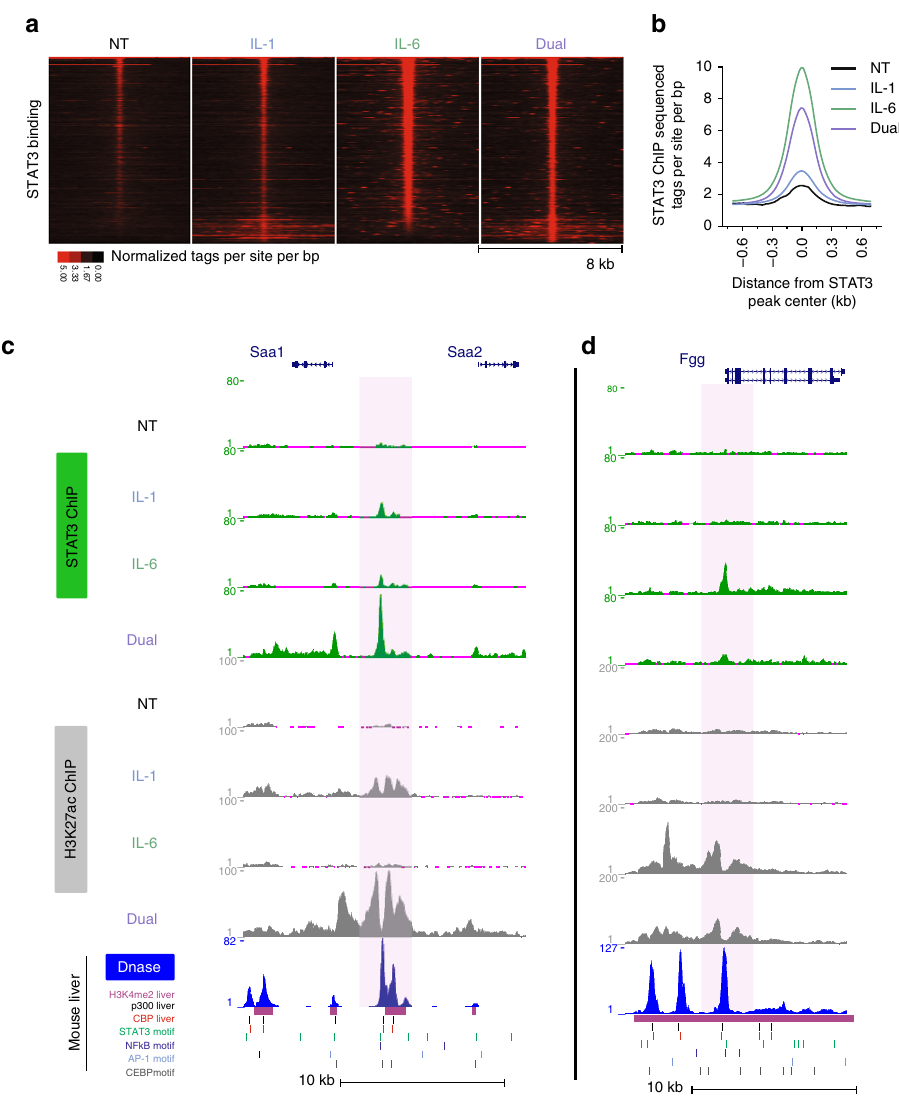
Fig. 3 STAT3 binding is generally increased by IL-6 but is augmented by IL-1 β at a subset of enhancers. a Heat map depicting STAT3 binding intensity at all STAT3 sites (sorted from high to low in the IL-6 condition). From a total of 2,975 peaks, 1.2% peaks ( n = 39) were called in non-treated cells, 8.3% ( n = 247) in IL-1-treated cells, 39.7% peaks ( n = 1182) in IL-6-treated cells and 59.5% peaks ( n = 1772) in dual-treated cells (see also Supplemental Data 3). b Overall STAT3 binding increases following IL-6 treatment. c , d Genome browser tracks showing IL-1 β -dependent activation of the Saa1/2 enhancer and the dependence in IL-1 β for maximal STAT3 binding ( c ). In contrast, at the Fgg locus, STAT3 binding is maximal in the presence of only IL-6 and is reduced upon IL-1 β addition ( d ). H3K27ac sites overlap with key enhancer marks: DNase hypersensitive sites, p300/CBP binding sites and H3K4me2. DNase hypersensitivity data adopted from Goldstein et al. 37 p300/CBP data adopted from Faure et al. 68 and H3Kme2 data adopted from Sun et al.